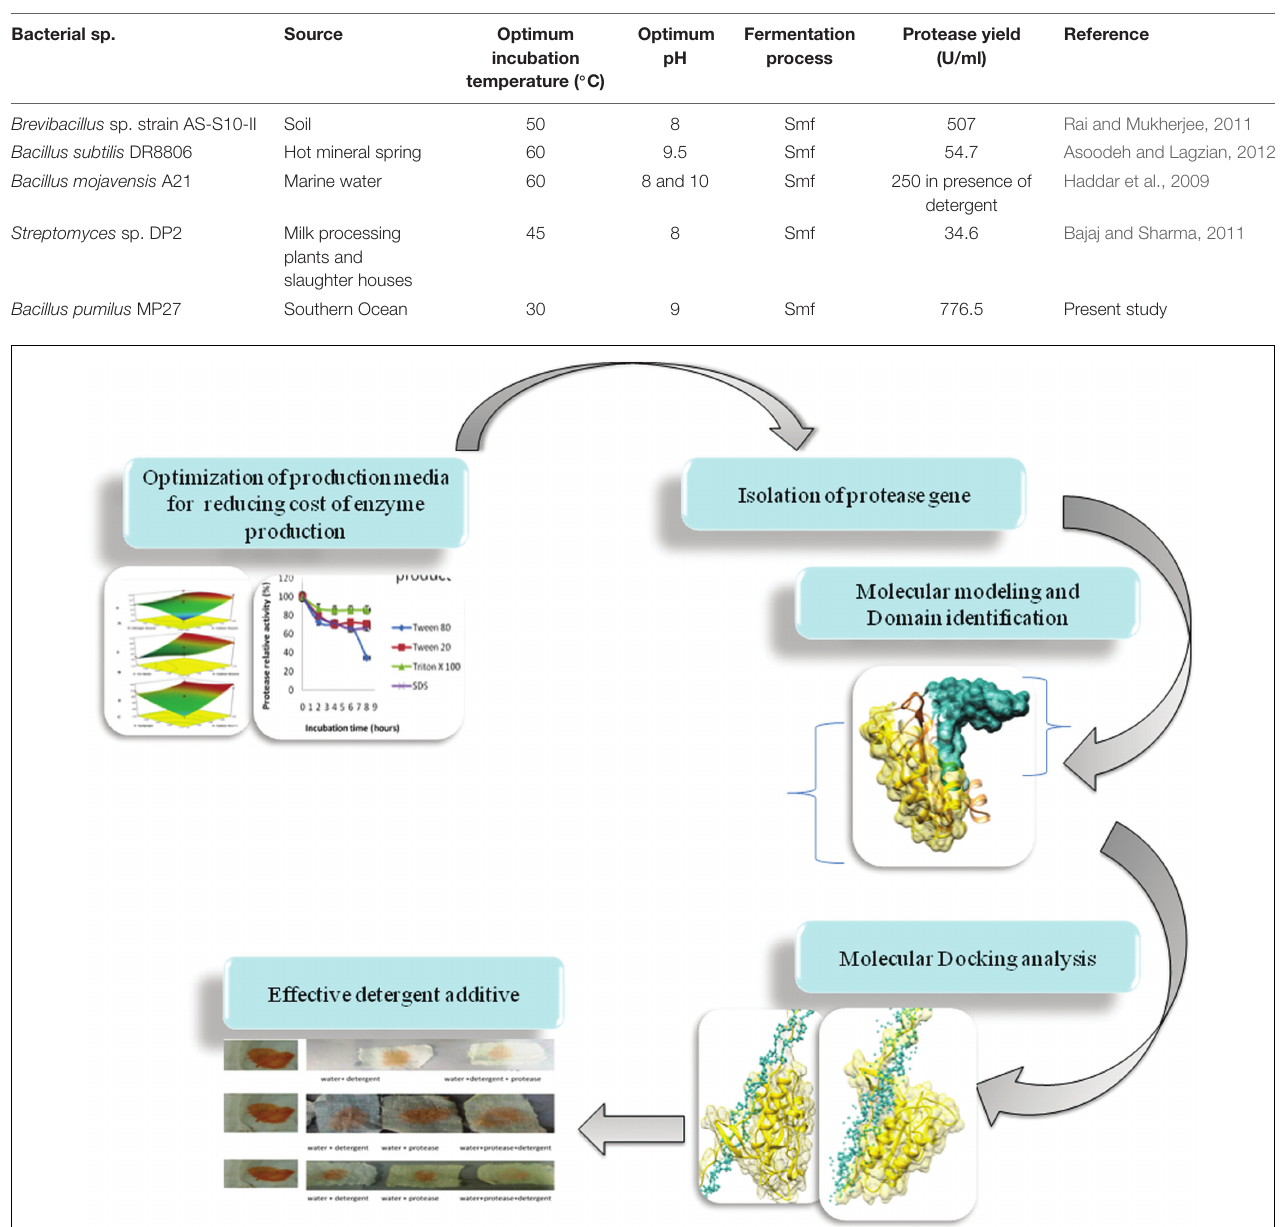
TABLE 6 | Comparision of protease activity from different bacterial species isolated at different temperatures. Bacterial sp.